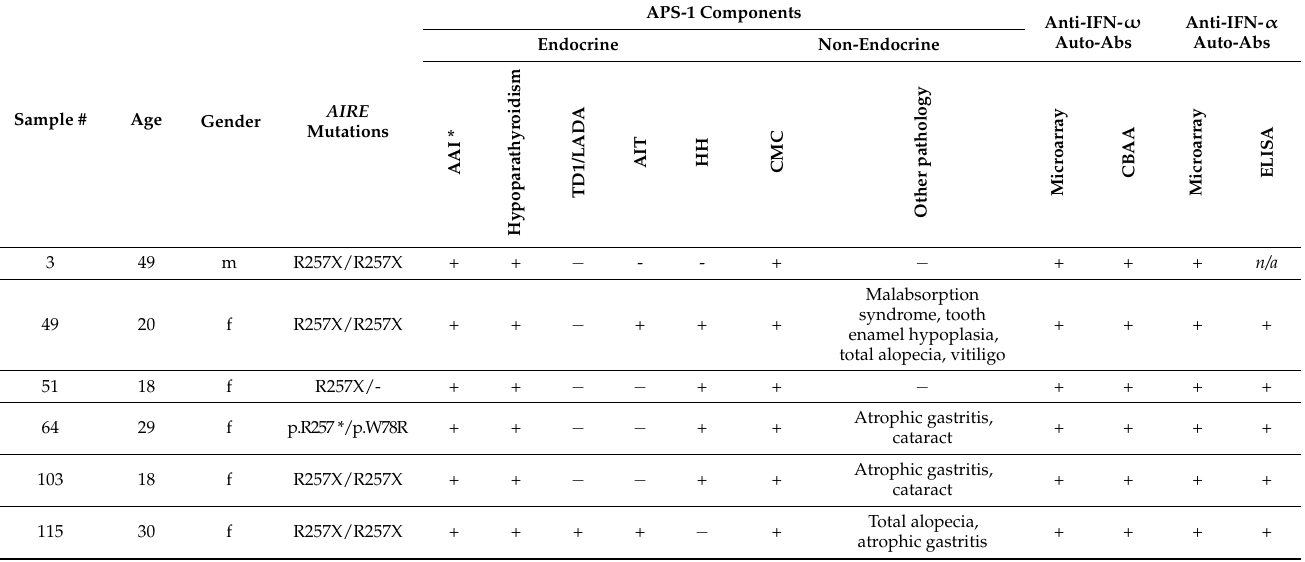
Table 1. Characteristics of the type I autoimmune polyglandular syndrome (APS-1) patients and results of testing serum samples for the presence of anti-omega-interferon (IFN- ω ) and anti-alpha- interferon (IFN- α ) autoantibodies using microarray-based, cell-based and enzyme-linked immunosor- bent